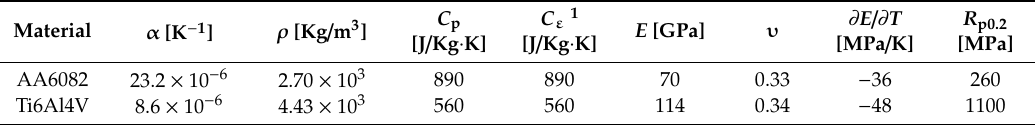
Table 1. Mechanical and thermo-physical characteristic of the considered